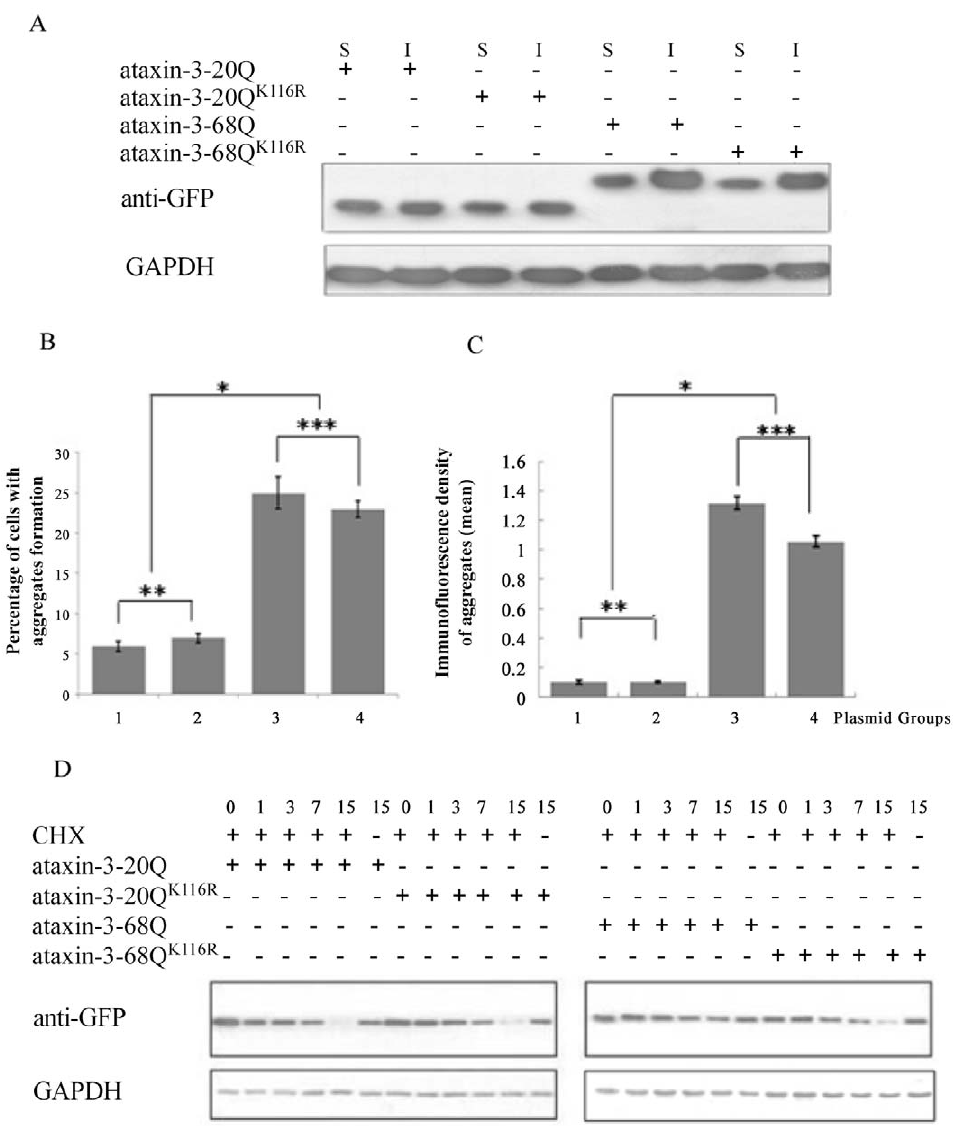
Figure 4. SUMO-1 modification partially increased ataxin-3-68Q stability. HEK293 cells were transfected with GFP-ataxin-3 or GFP-ataxin- 3 K166R . Immunoblotting analysis showed difference between the soluble (S) and insoluble (I) ataxin-3 in 20Q and 68Q with or without K166 (A). At 48 h after transfection, both aggregates formation cells and its immunoflurescence density were quantified. Plasmid groups: 1. GFP-ataxin-3-20Q; 2. GFP-ataxin-3-20Q K166R ; 3. GFP-ataxin-3-68Q; 4. GFP-ataxin-3-68Q K166R . Statistical significance was assessed with a one-way ANOVA. The amount of aggregates formation cells: 1 and 3: P , 0.05 (*); 1 and 2: P . 0.05 (**); 3 and 4: P . 0.05 (***) (B). Immunoflurescence density of aggregates: 1 and 3: P , 0.05 (*); 1 and 2: P . 0.05 (**); 3 and 4: P . 0.05 (***) (C). At 24 h after transfection, cells were treated with CHX (100 m g/ml) to prevent protein synthesis. Cells were harvested at 0, 1, 3, 7, 15 h after CHX treatment, subject to 12% SDS-PAGE, and analyzed by immunoblotting with anti-GFP antibody